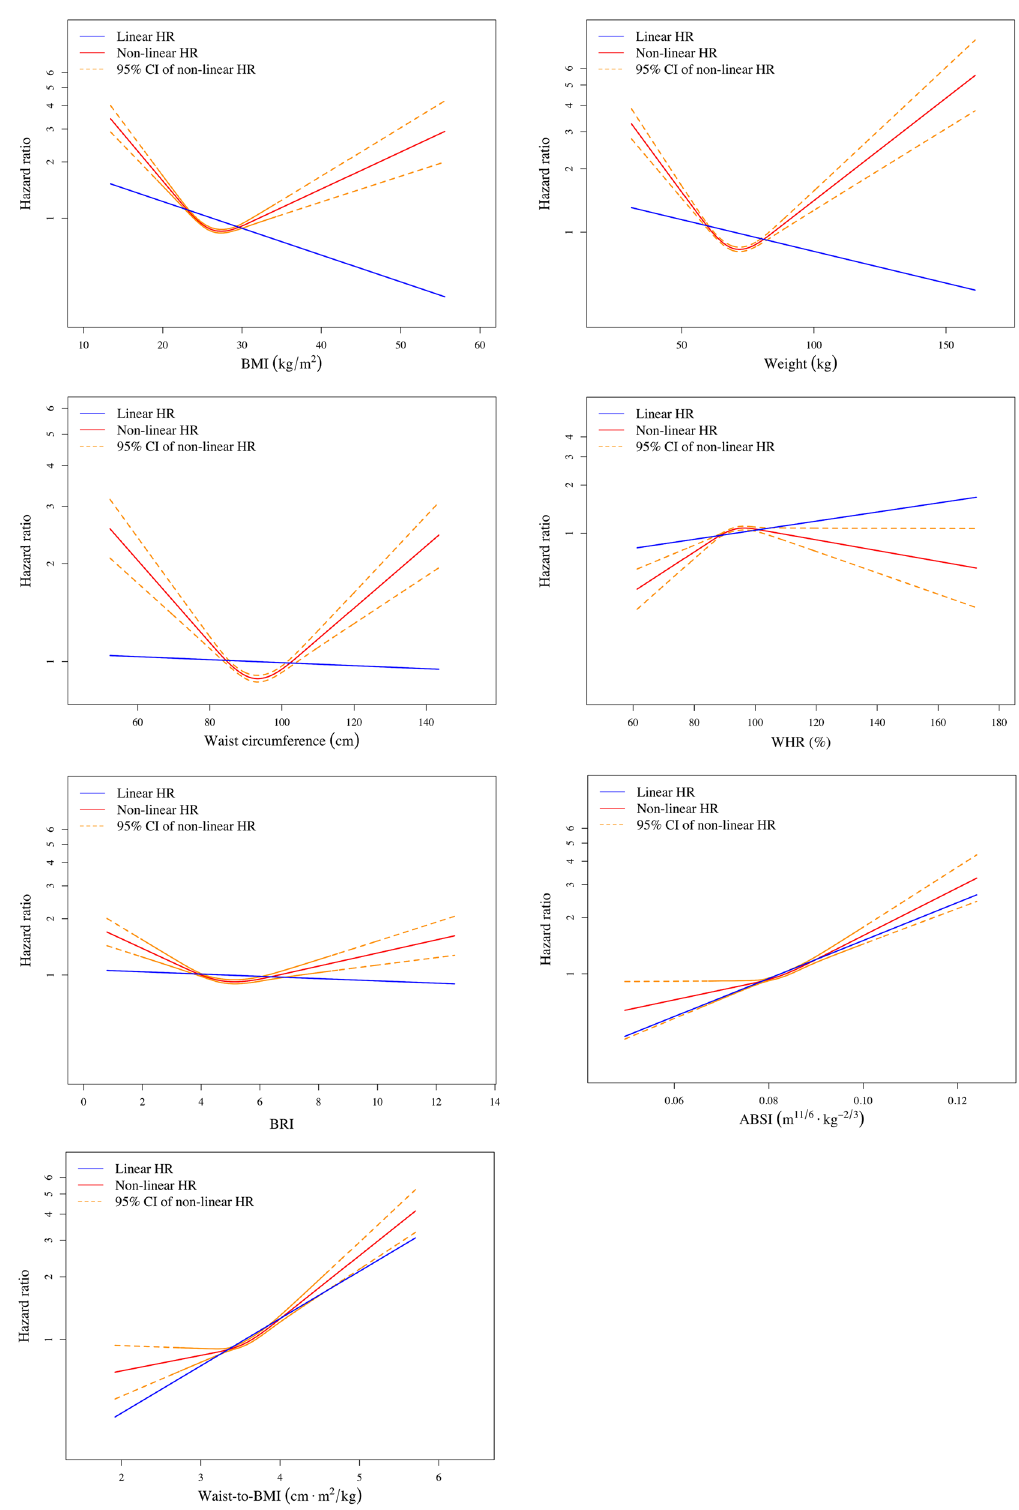
Figure 1. Dose–response curves for various anthropometric parameters and risk of MACE. The red line and orange dashed line represent the point estimates and 95% confidence intervals from the non-linear analysis using the cubic spline regression. The blue line represents the point estimates from the linear analysis using the Cox proportional hazards